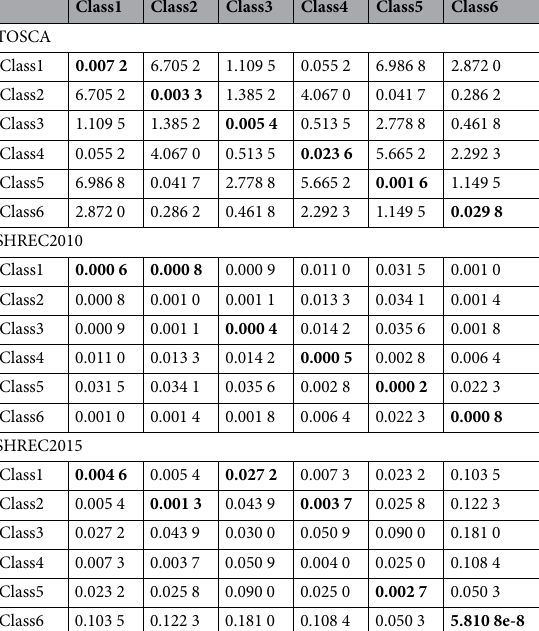
Table 2. Matching results using SIMHW descriptor based on TOSCA, SHREC2010 and SHREC2015